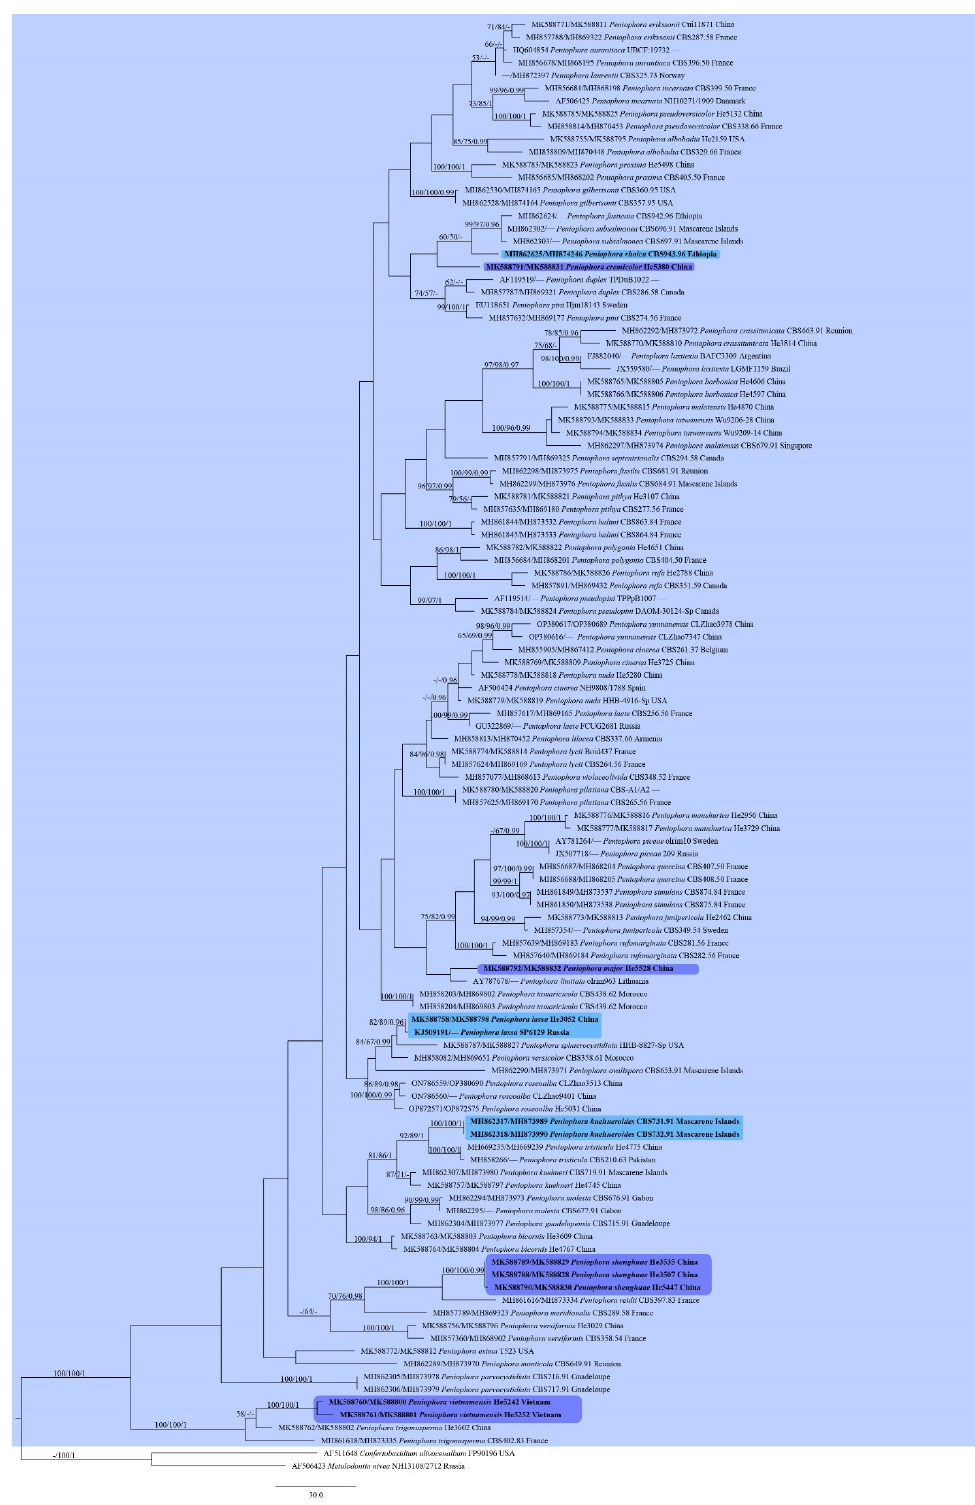
Figure 2. Phylogenetic tree obtained from maximum parsimony analysis of ITS-28S sequence data of Peniophora s.l. Branches are labeled with parsimony bootstrap values ( ≥ 50%, front), likelihood bootstrap values ( ≥ 50%, middle) and Bayesian posterior probabilities ( ≥ 0.95, back). New species (purple) and new combinations (blue) are set in